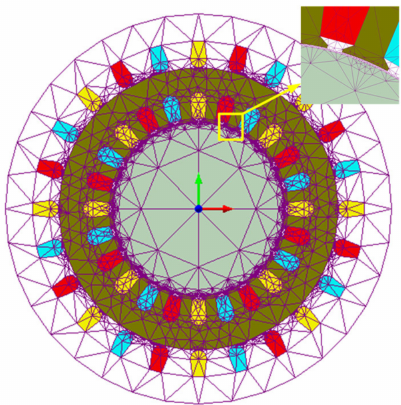
Figure 3. Two-dimensional finite element model of 120 ◦